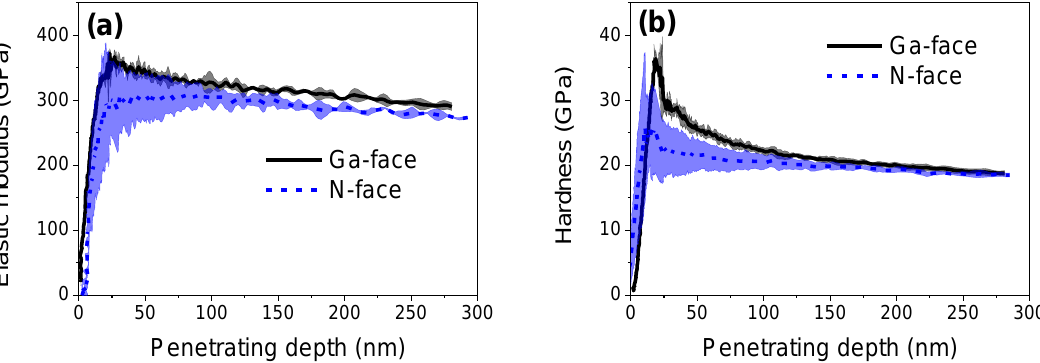
Figure 3. Elastic modulus ( a ) and hardness ( b ) vs. indentation depth on Ga- and N-faced GaN samples. The filled areas under the curves show the standard deviation for multiple repeated experiments.